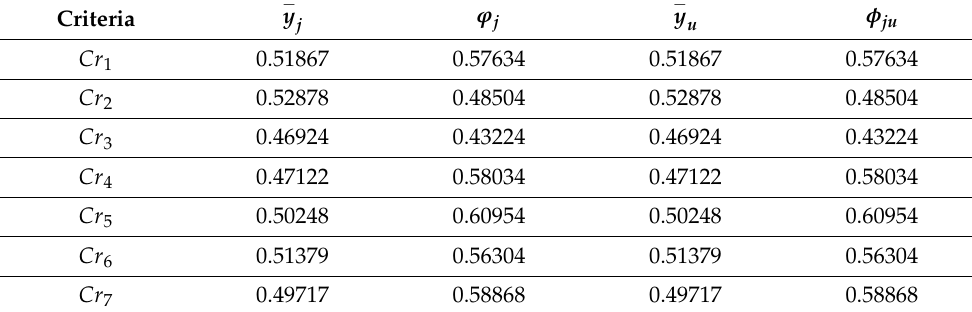
Table 8. Amounts of